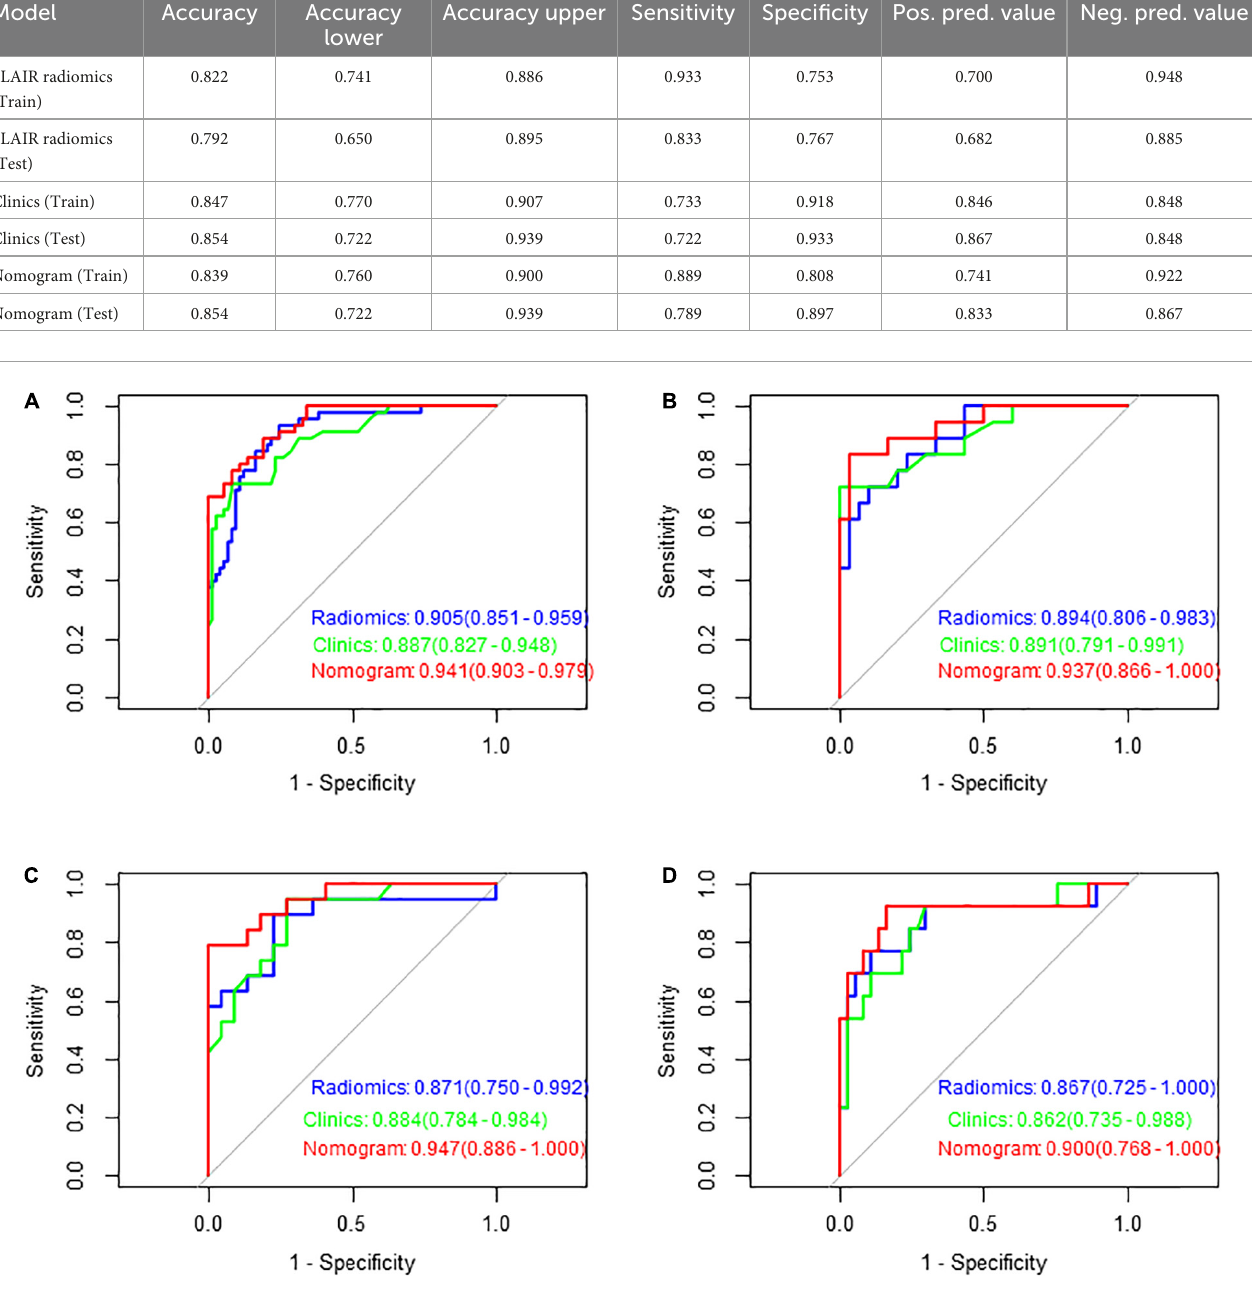
FLAIR radiomics and the clinical model. The sensitivity, specificity, accuracy, negative predictive value and positive predictive value of FLAIR radiomics, clinical features and clinical-FLAIR radiomics